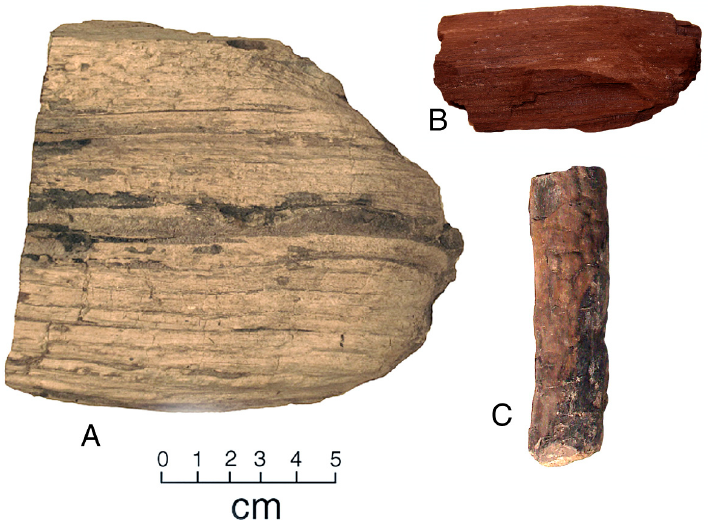
Figure 3. Fossil wood from Nanaimo Group strata. ( A ) Puntledge River. ( B ) Shelter Point. ( C ) Denman Island.